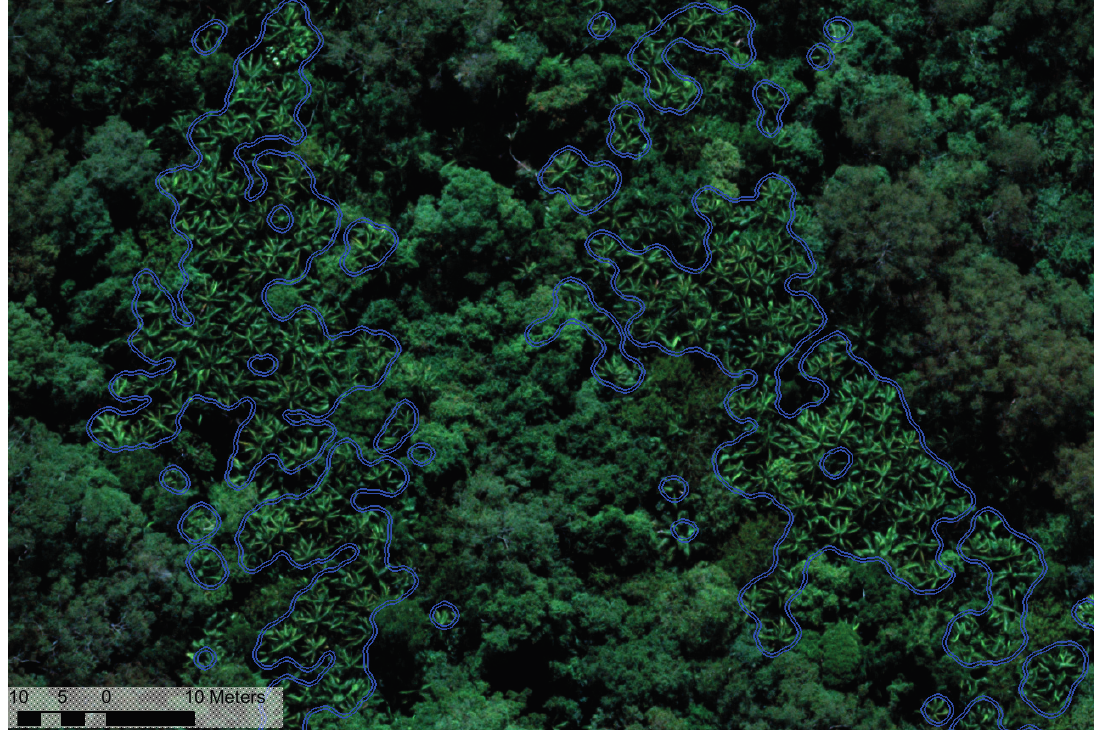
Figure 14. Palms along drainage lines within forested areas. Location: 152°56 ′ 20 ″ E, 26°49 ′ 10 ″